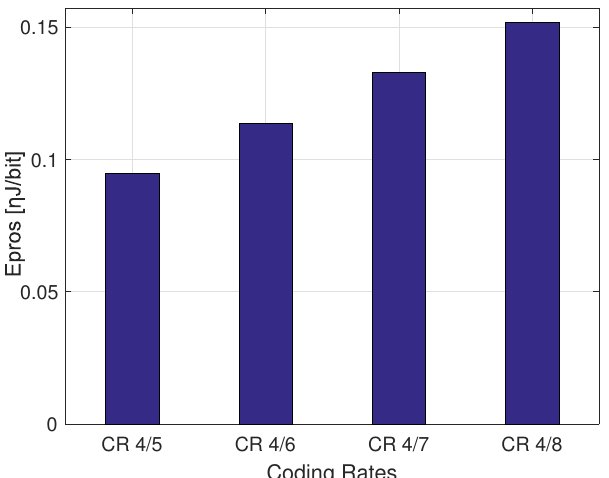
Figure 8. The distribution of the consumed energy for processing when transmitting a PL = 30 Bytes using setting SF 7 with different